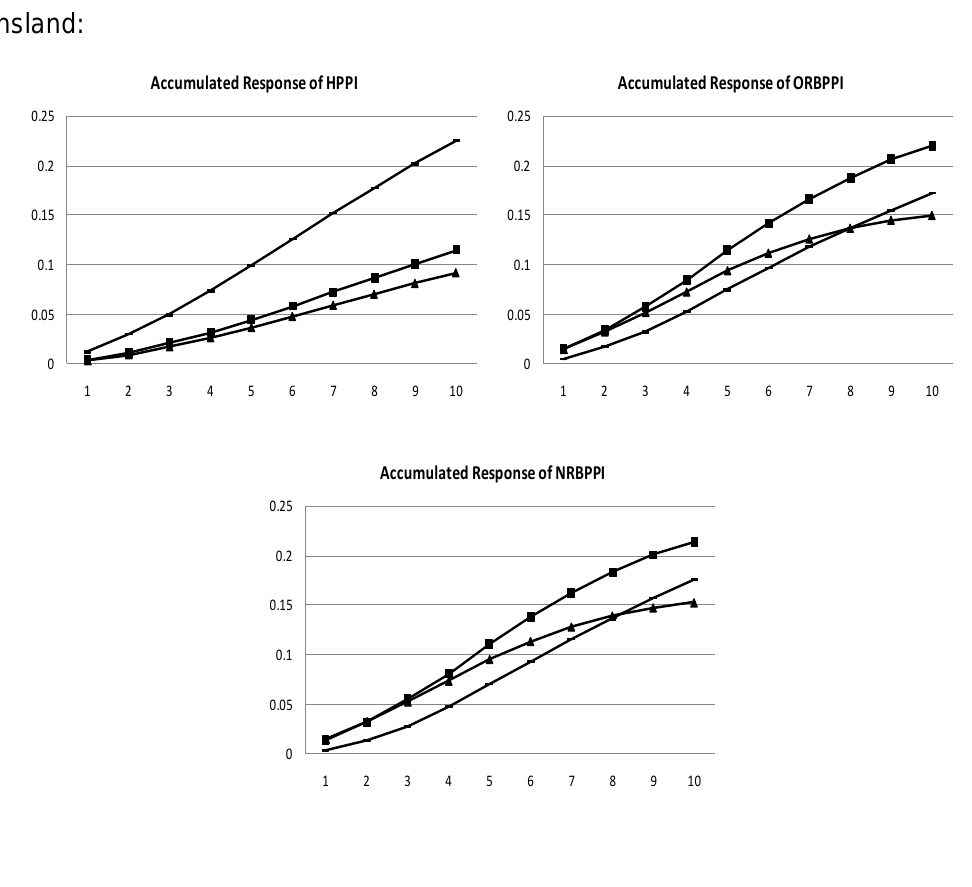
Liu, J and London, K A (2010) ‘Convergence among the sub-markets in Australian regional building construction sector’ , Australasian Journal of Construction Economics and Building, 10 (4)